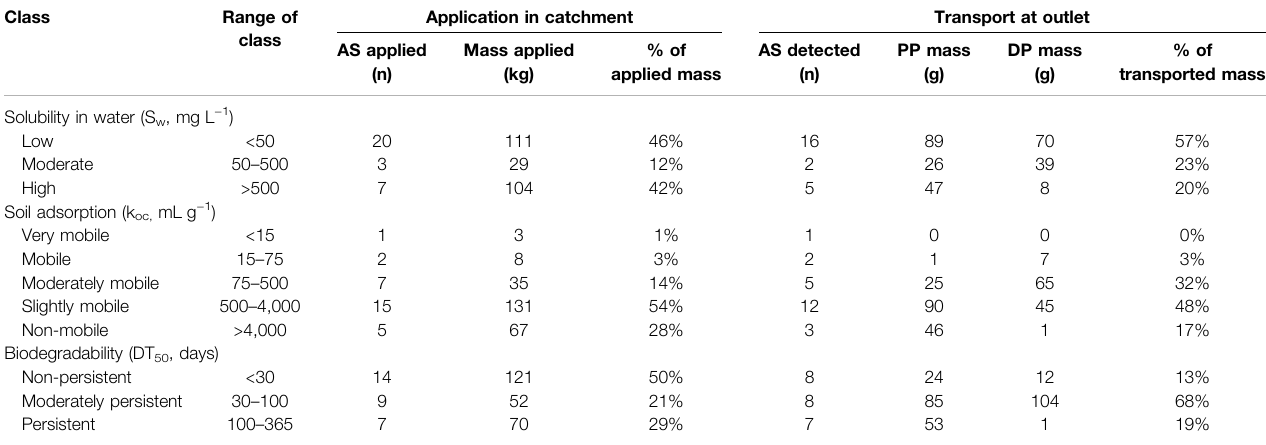
TABLE 1 | Overview of application and transport of AS in relation to chemical characteristics.